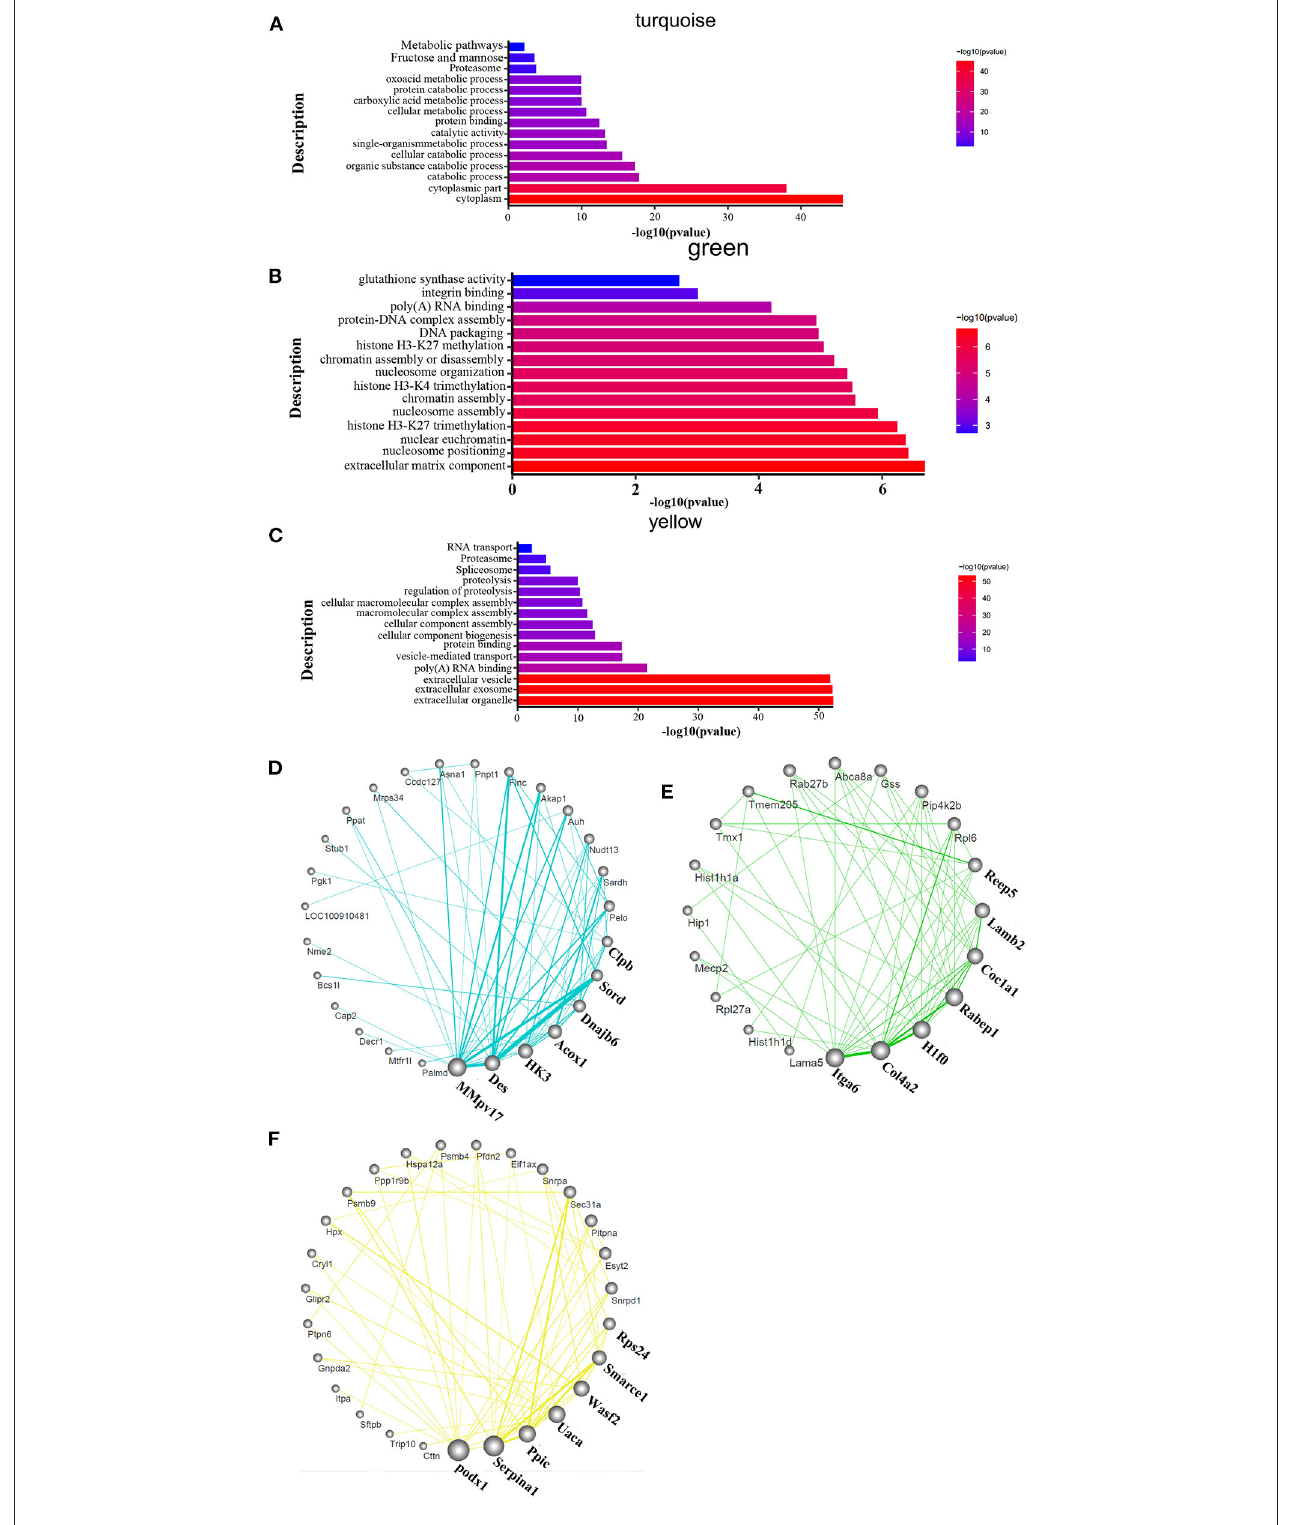
FIGURE 4 | Functional enrichment analysis and hub molecular identification of co-expression networks based on protein data. (A–C) Biological functions enriched in organ-specific modules; bar length indicates the –log 10 of the P -value from the Fisher’s exact test. (D–F) Organ-specific co-expression hub networks. Edge width represents connectivity strength. Node size represents the level of